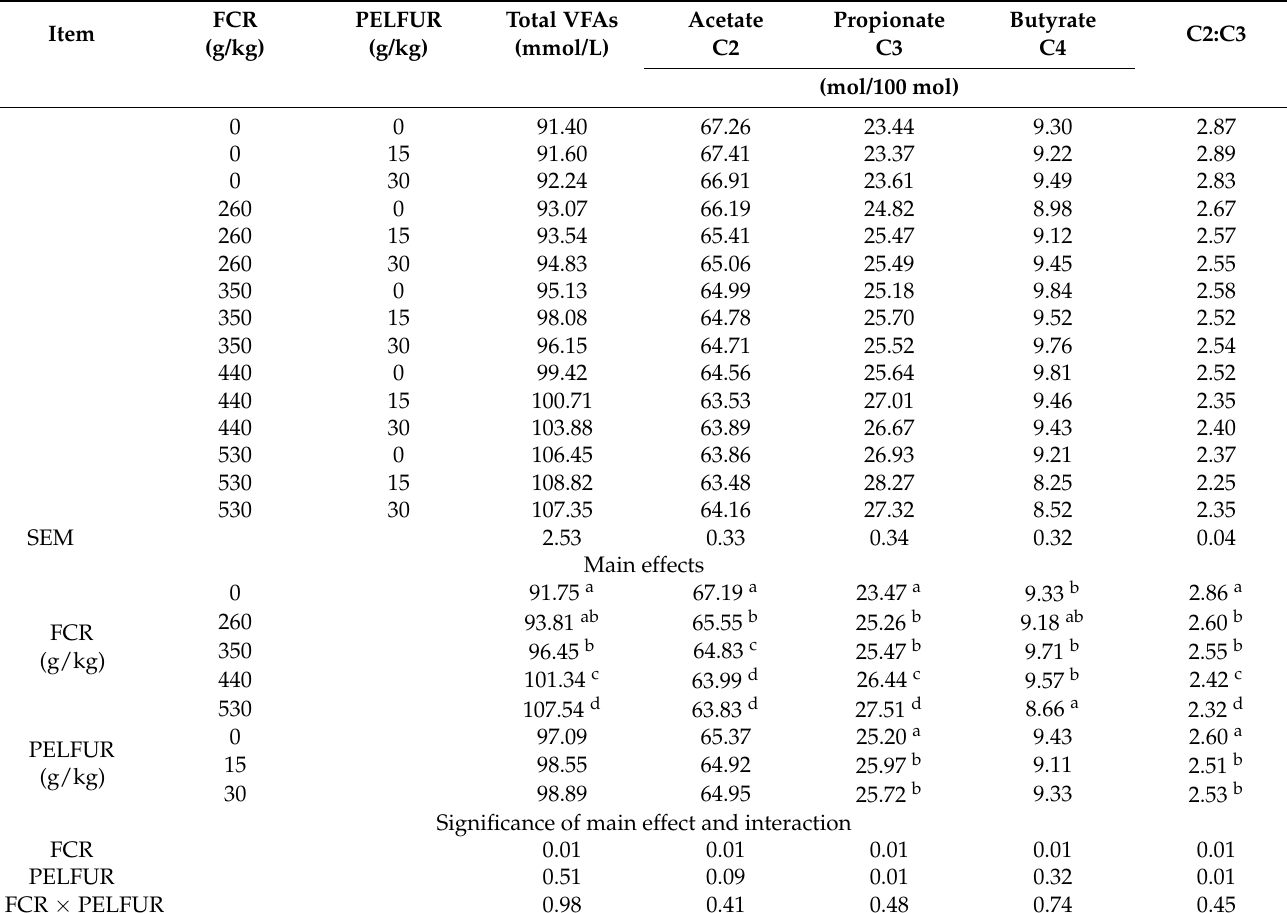
Table 5. The effect of fresh cassava root (FCR) with pellets containing high sulfur (PELFUR) on volatile fatty acid (VFA)